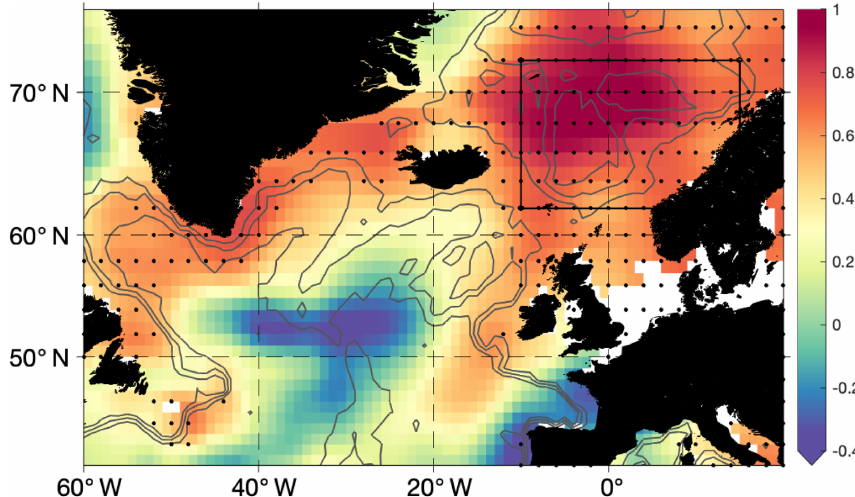
Figure 8. Correlation analysis between the leading mode of temperature variability at 100m in the eastern Nordic Seas (see black box and Fig. 7a) against temperature anomalies at every grid point at the same depth. The data (not detrended) have been deseasonalized and annually averaged before the analysis. Black dots indicate significance at the 95% confidence level according to a random phase test (Ebisuzaki, 1997). Grey contours depict the 1000, 2000 and 3000m depth